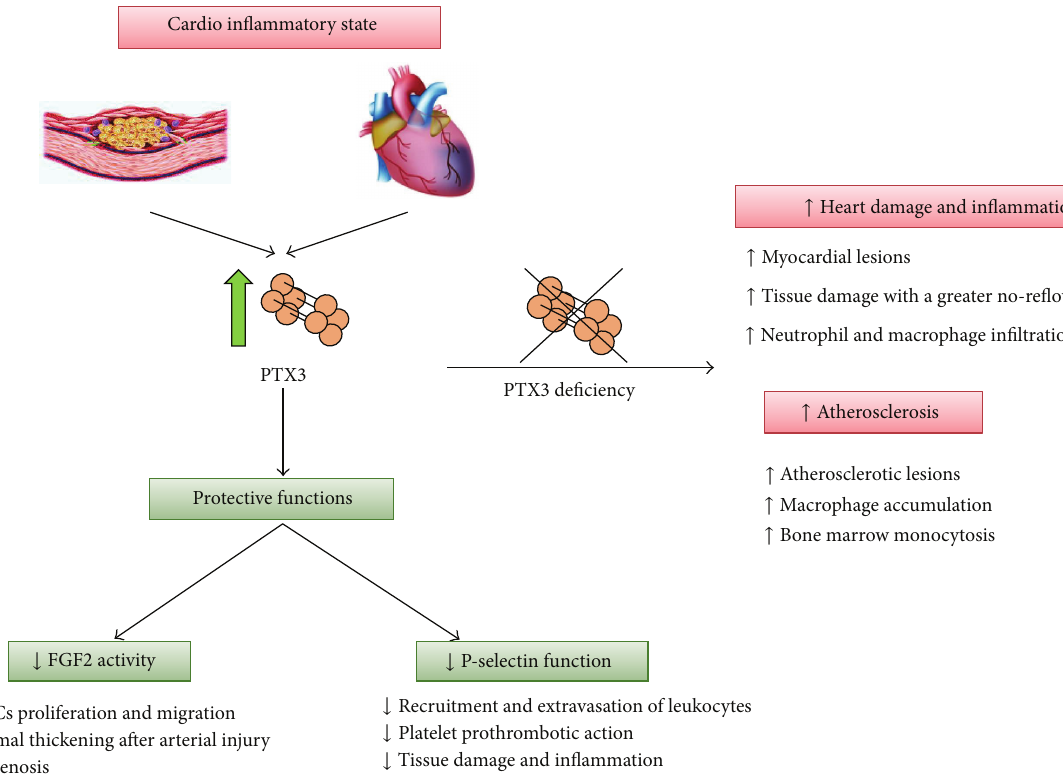
Figure 1: Effects of PTX3 in cardiovascular diseases. PTX3 plasma levels rapidly increase during atherosclerosis and MI in humans and mice. PTX3 could then interact with FGF2 and/or P-selectin and exert cardiovascular protective activities. On the contrary, PTX3 deficiency leads to increased heart damage and inflammation after MI and